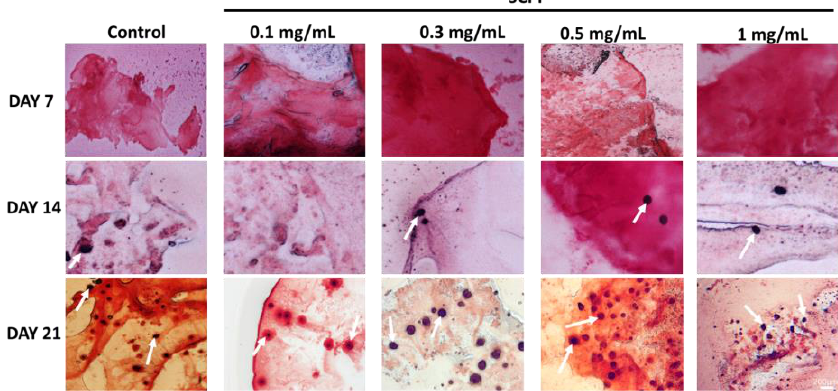
Figure 10. 20-micron cryosections stained with Alizarin red for 7, 14, and 21 days. Early nodules are seen on day 14, with the greatest amount of nodule formation at day 21 for each group. White arrows indicate positive alizarin red staining due to osteoblast calcium deposition.